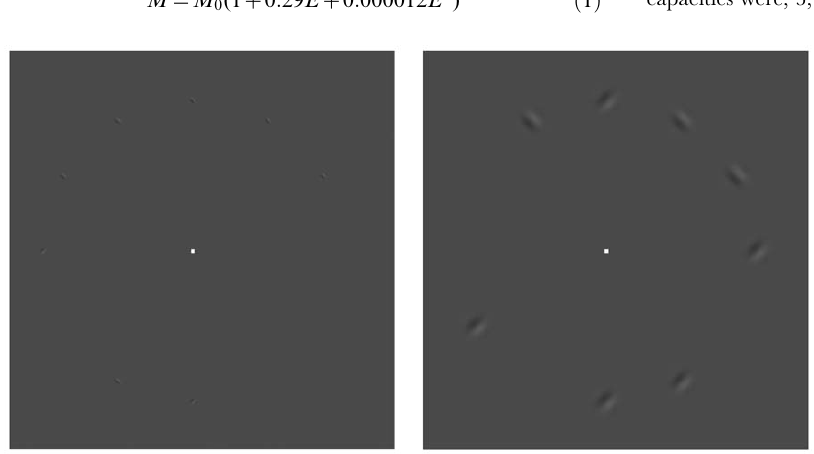
Figure 1. Example stimuli. Fixate on the white square and enumerate the number of gratings in the periphery. Small gratings are harder to enumerate than large gratings. Sizes were not scaled in Experiment 1 (left) but were scaled in Experiment 2 (right) according to a cortical magnification factor. There are 8 gratings in both of these panels.